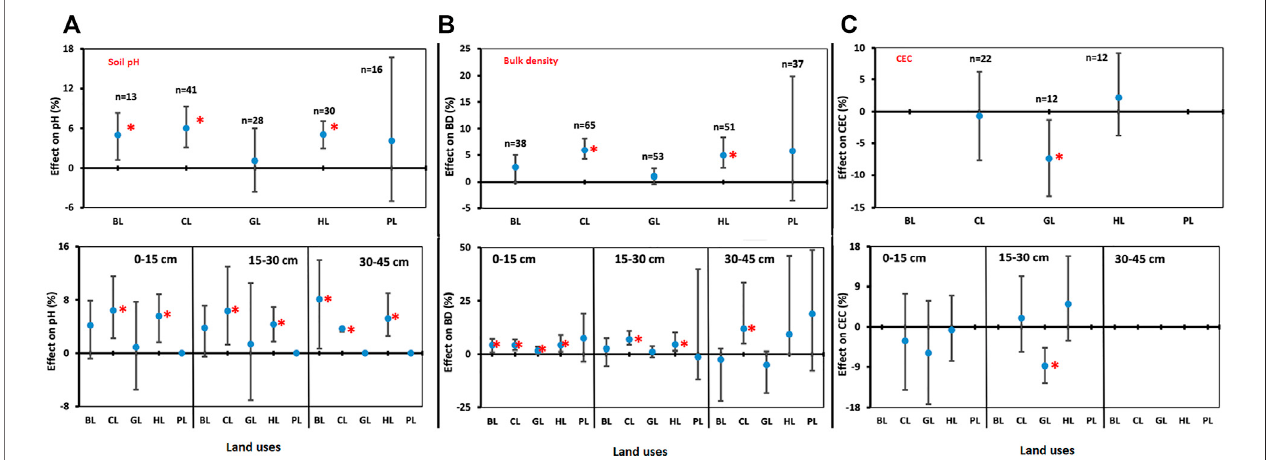
FIGURE 3 | Comparisons of soil properties. (A) Soil reaction (pH). (B) Bulk density (BD) and (C) cation exchange capacity (CEC) under various land uses (BL, CL, GL,HL,andPL)withFLbasedonsoildepths(0 – 15 cm,15 – 30 cm,and30 – 45 cm).Theerrorbarsshow95%con fi denceintervals(CI),andthedifferenceissigni fi cantif it does not pass zero. *indicates signi fi cant difference at p -value is less than 0.05. Here, Forest land (FL) is used as control, BL — Barren land, CL — Cultivated land, GL — Grassland, HL — Horticulture land, and PL — Plantation land.